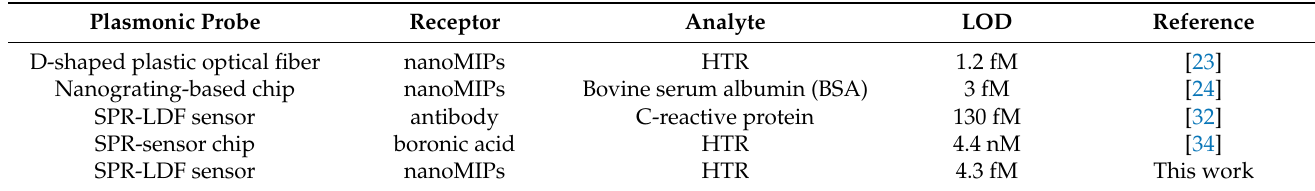
Table 3. Comparative analysis between plasmonic biosensors of